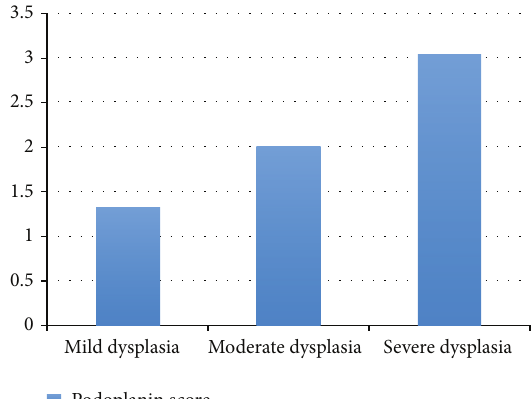
Figure 1: Graph showing increasing expression of podoplanin in oral leukoplakia as the grade of dysplasia increases.